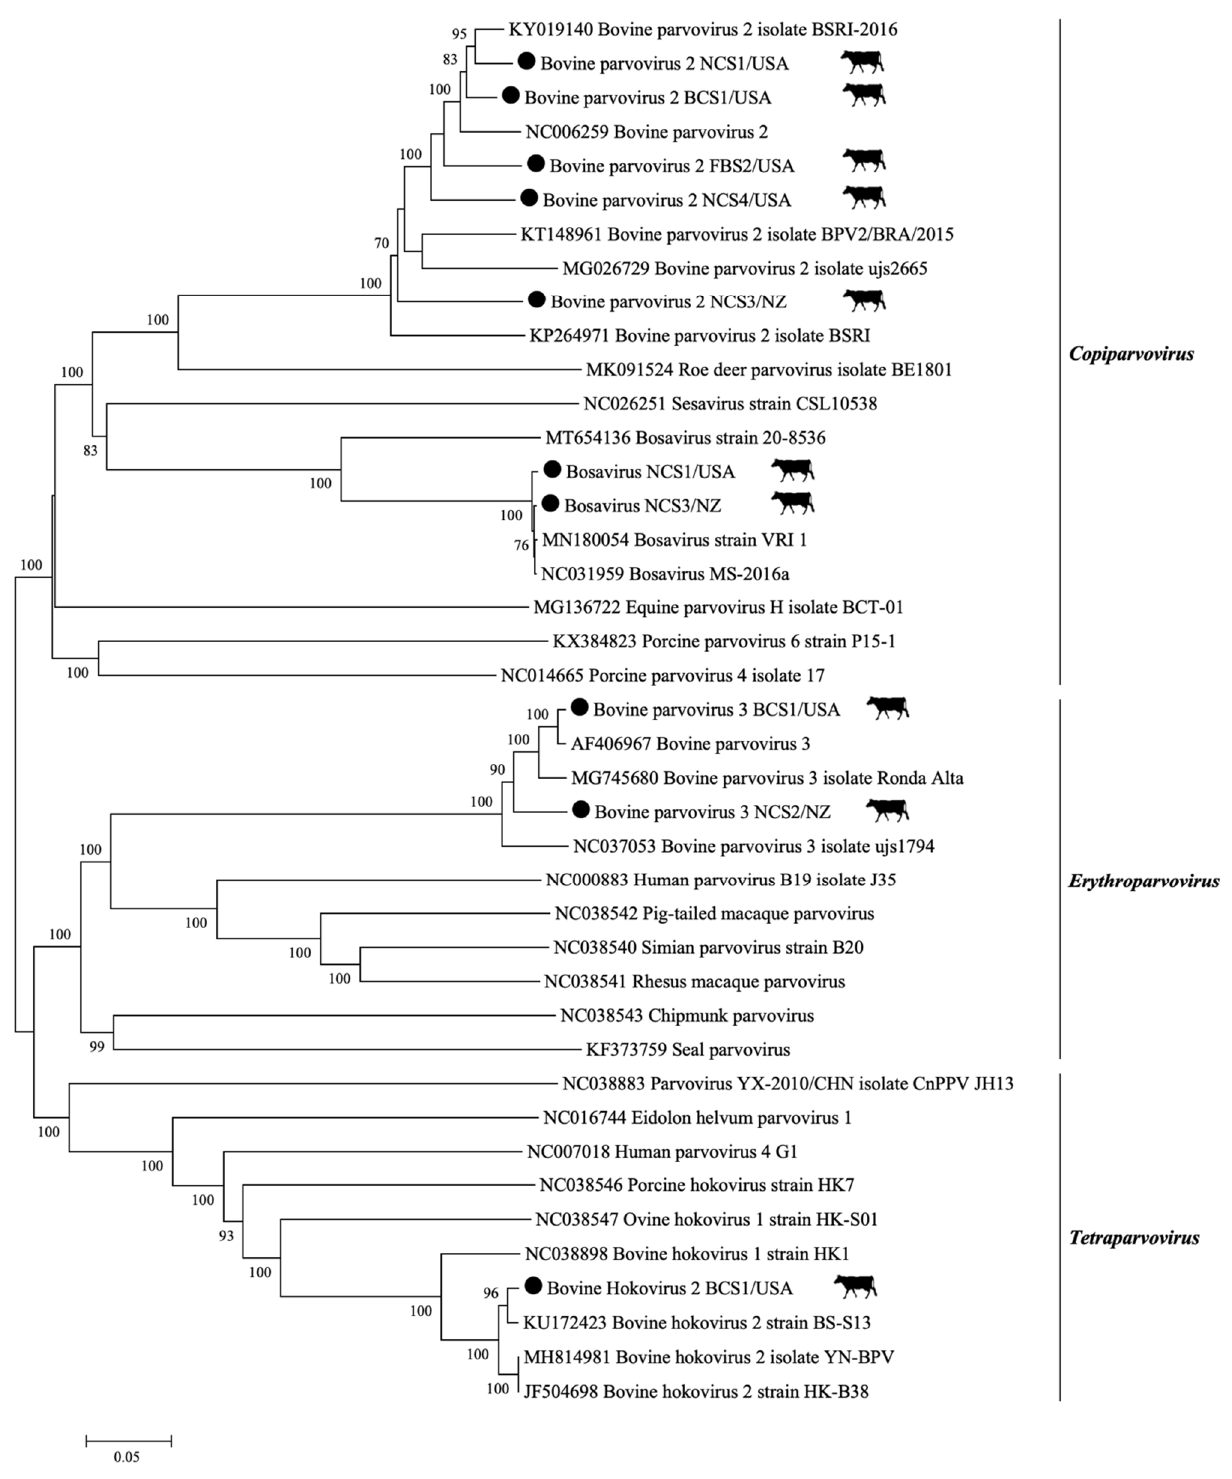
Figure 1. Genetic characterization of members of the Parvoviridae family was detected in the present study. Representative genomes belonging to the Parvoviridae family were selected from GenBank at the National Center for Biotechnology Information (NCBI). The nucleotide phylogenetic tree was constructed using the Neighbor-Joining (NJ) method based on a p-distance model using the full coding genome. Analyses were conducted with 1000 bootstrap replicates. Complete coding genomes obtained are indicated by the black dots and the sequences were deposited in GenBank under the accession numbers MZ502227, MZ502228, MZ502229, MZ502230, MZ502231, MZ502232, MZ502233, MZ502234, MZ502235, and MZ502236.